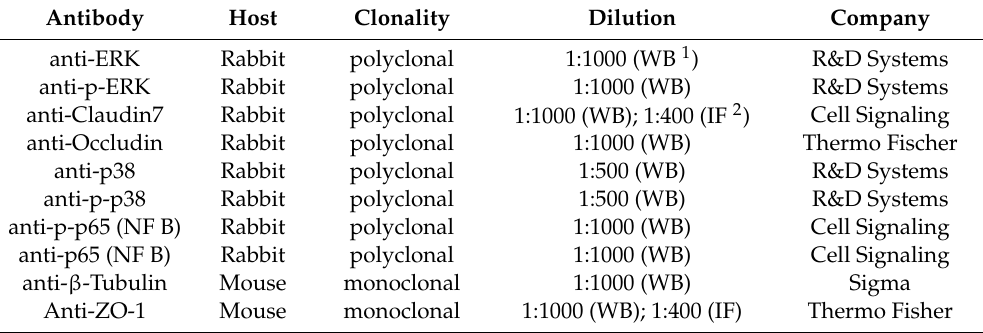
Table 1. Antibodies used for Western blot and